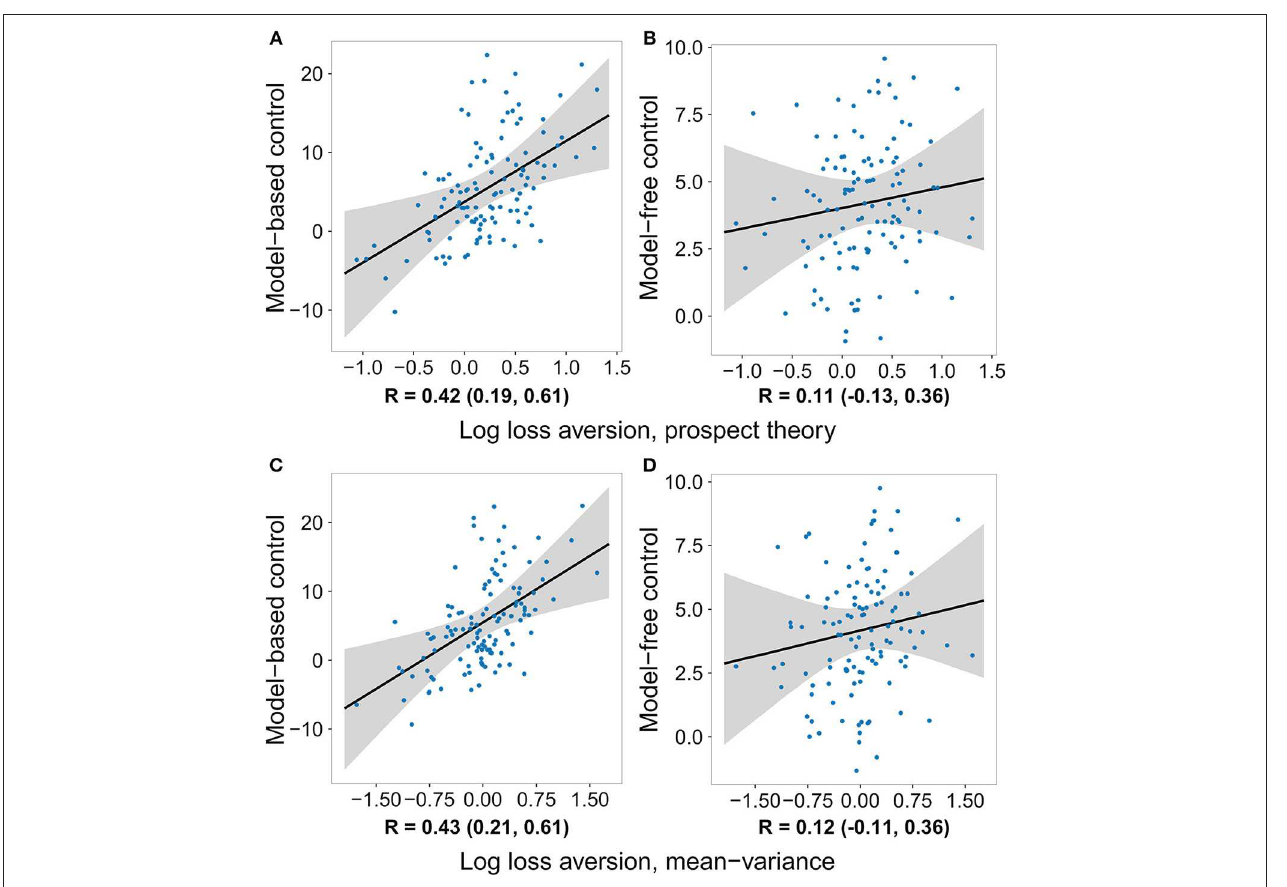
FIGURE 2 | The degree to which individuals deploy each decision system versus the logarithm of their loss aversion weight, after removing the effects of risk aversion and the gambling task inverse softmax temperature. Control estimates are based on a hybrid reinforcement learning model fit to the two-step data, while loss aversion was estimated using two different utility functions applied to the gambling task data. Each dot represents the medians of one subject’s parameter estimates, the black line is the median regression line, and the gray area outlines the 95% credible interval. Below each panel is a summary of the posterior distribution of the respective correlation coefficient. The posterior is a more appropriately conservative summary of the relationship between the two quantities than the correlation between the median values, because it takes into account the uncertainty in each subject’s parameter estimates. A relationship between loss aversion and model-based control can be seen using both utility functions, while a relationship with model-free control is not seen with either one. (A) Model-based control vs. log loss aversion measured using the prospect theory model. (B) Model-free control vs. log loss aversion measured using the prospect theory model. (C) Model-based control vs. log loss aversion measured using the mean-variance model. (D) Model-free control vs. log loss aversion measured using the mean-variance model.